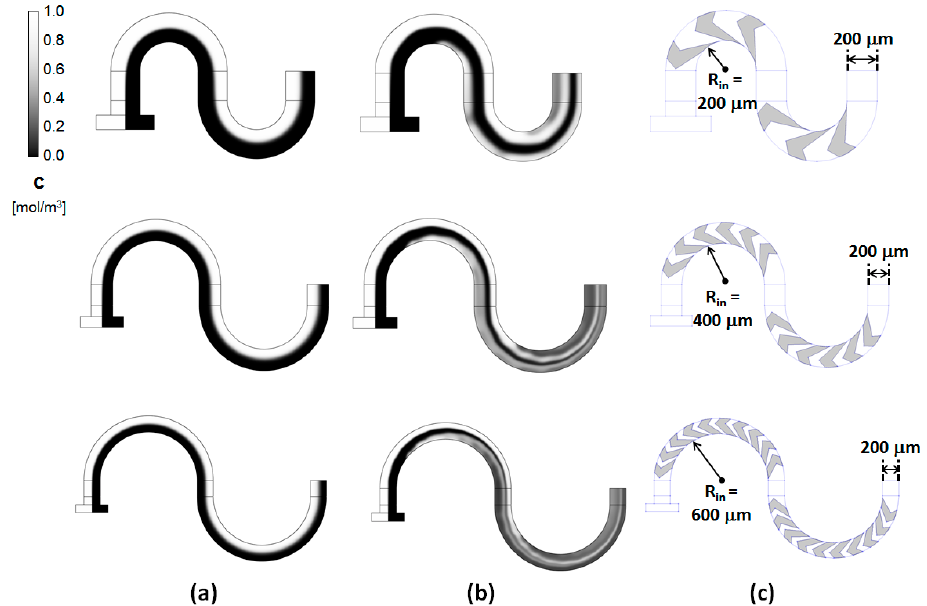
Figure 5. Concentration distributions along the center planes of the main channel (i.e., 33 μ m below the top surface) for ( a ) simple serpentines and ( b ) grooved serpentines micromixers; ( c ) The configuration of the corresponding grooves placed on the bottom of the new designs for R in = 200 μ m, 400 μ m, and 600 μ m, respectively.